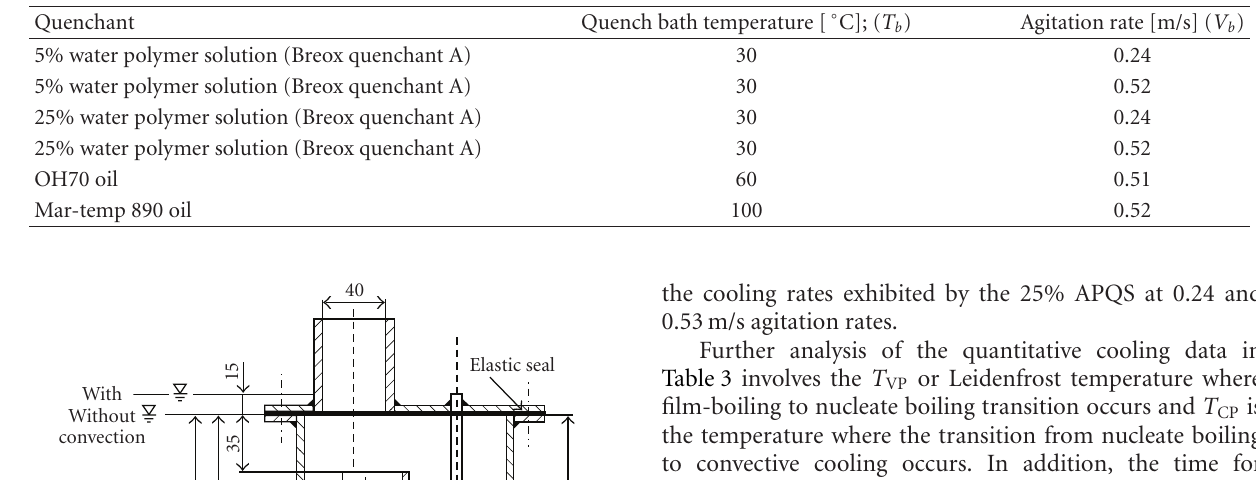
Table 2: Quenching media used in hardening of steel.